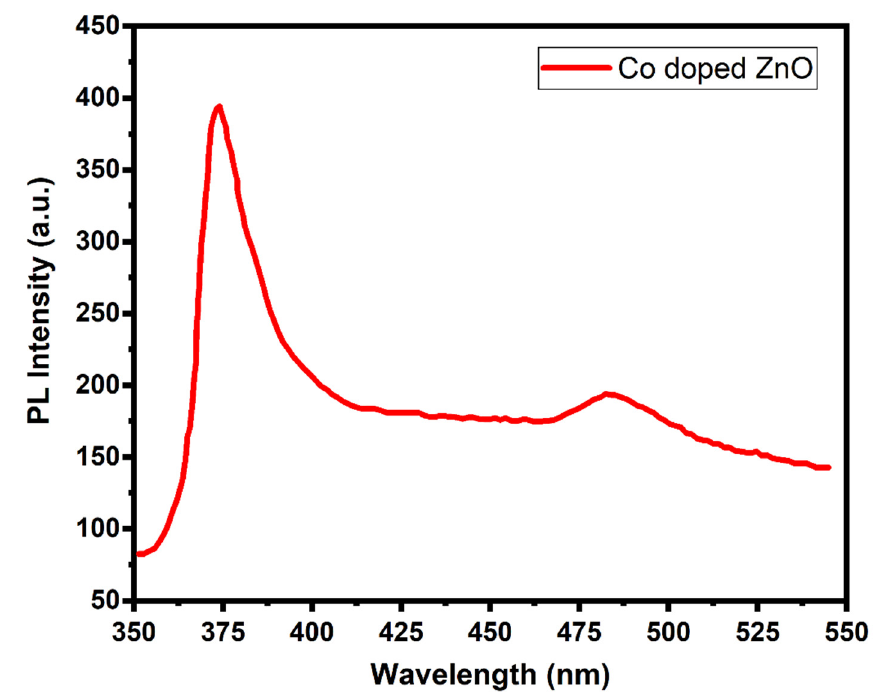
Figure 7. Photoluminescence spectra of Co-doped ZnO-MCs.